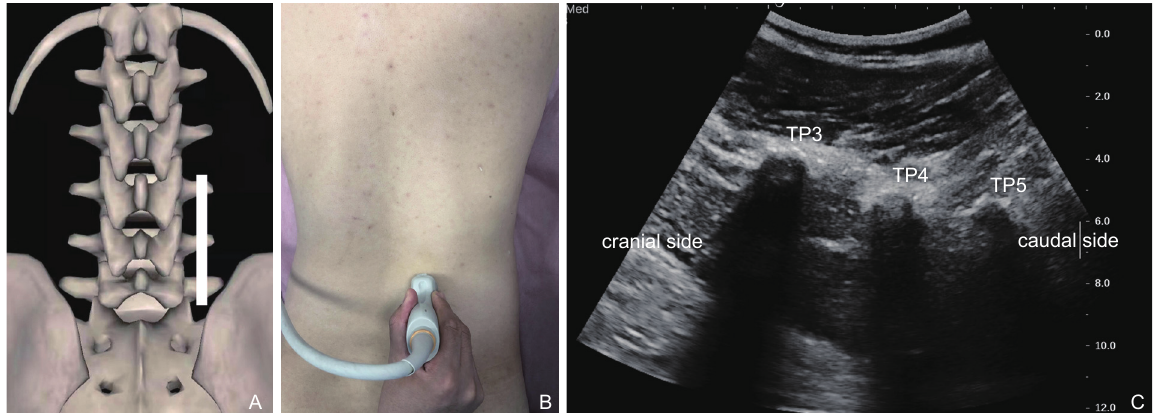
Figure 1 Longitudinal section of the transverse processes from L3 to L5. (A) The white line indicates the location of the probe on the reconstructed CT image. (B) The position of the probe on human skin. (C) Ultrasound image of the L3-L5 transverse processes under the probe. TP3, transverse process of L3; TP4, transverse process of L4; TP5, transverse process of L5.